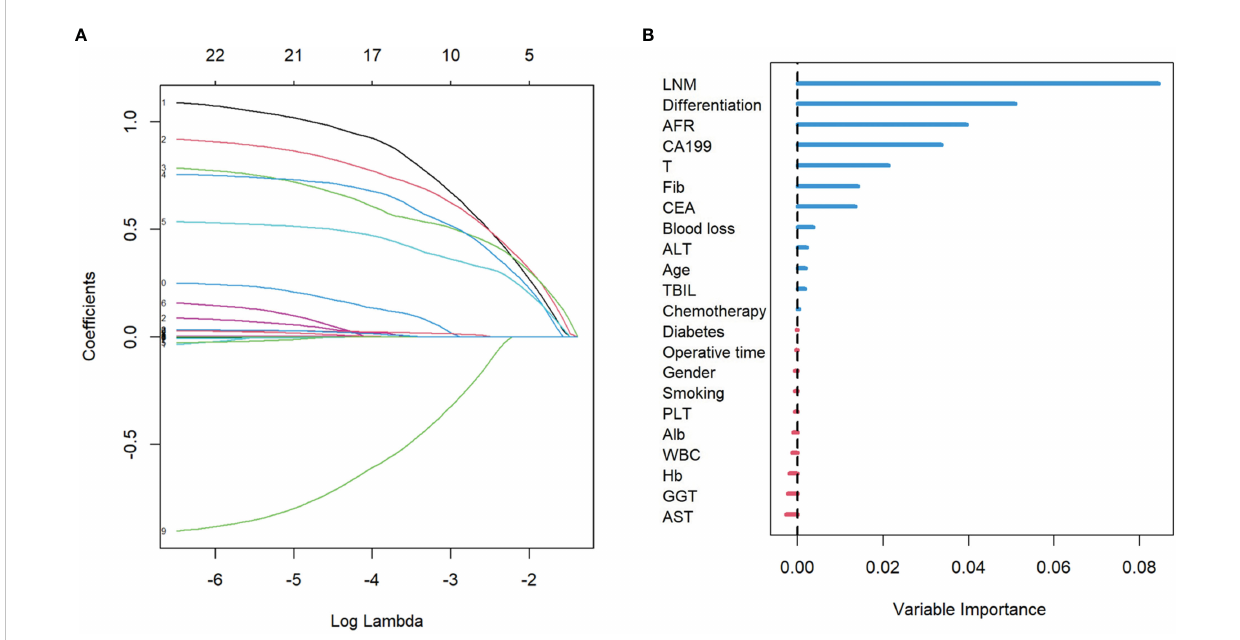
FIGURE 1 The results of LASSO regression analysis and the RSF plot for models. (A) LASSO coef fi cient pro fi les of the expression of 22 variables. (B) The length of the horizontal axis where each variable is located represents the variable ’ s contribution to the outcome. LASSO, least absolute shrinkage and selection operator; RSF, random survival